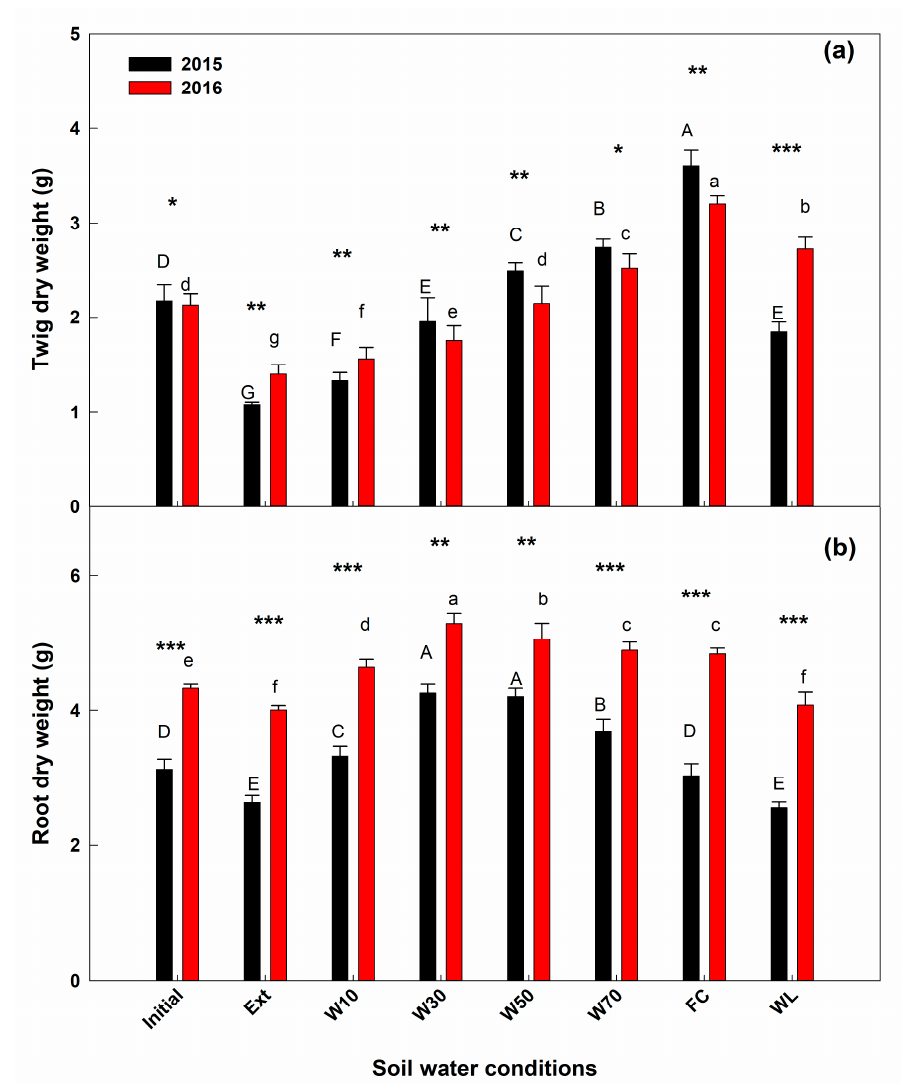
Figure 1. Changes in biomass in response to different water treatments. The plot shows the biomass at the beginning of the experiments (initial) and at the end of the 10-day treatments in 2015 (black bars) and 2016 (red bars) for ( a ) twigs and ( b ) roots. The treatments are Ext: extreme drought, W10: 10% of field capacity (FC), W30: 30% of FC, W50: 50% of FC, W70: 70% of FC, and WL: permanently waterlogged. Asterisks indicate a significantly different values (*, p < 0.05; **, p < 0.01; ***, p < 0.001) between 2015 and 2016. Different letters indicate significant differences between treatments in each year. The upper-case letter refers to 2015 and the lower-case letter refers to 2016.